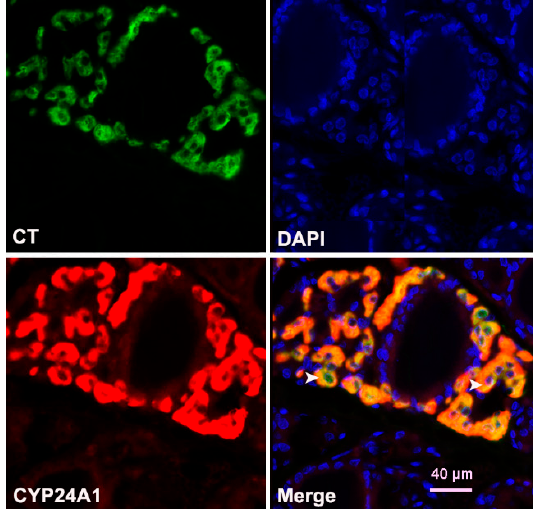
Figure 7. Double-immunofluorescence demonstrating colocalization of CYP24A1 and calcitonin (CT) in the thyroid of Orx + Vit. D 3 rats. CYP24A1 (red fluorescence) was highly expressed by CT-containing cells (green fluorescence). Colocalization of CYP24A1 to CT-producing cells is depicted by yellow/orange color and accentuated by white